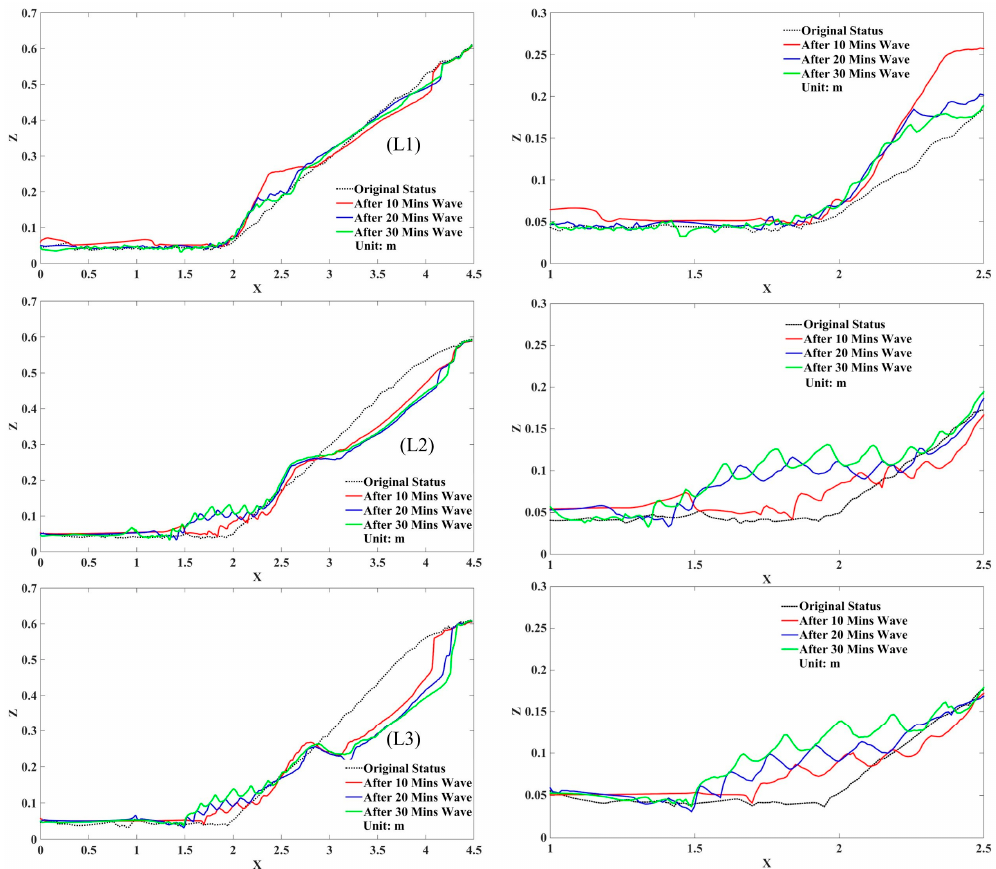
Figure 9. Beach evolution analysis based on beach profiles L1 through L3 (left column), with L3 in the middle of the wave tank. The column on the right includes the plots of corresponding areas (1–2.5 m) with subtle differences.